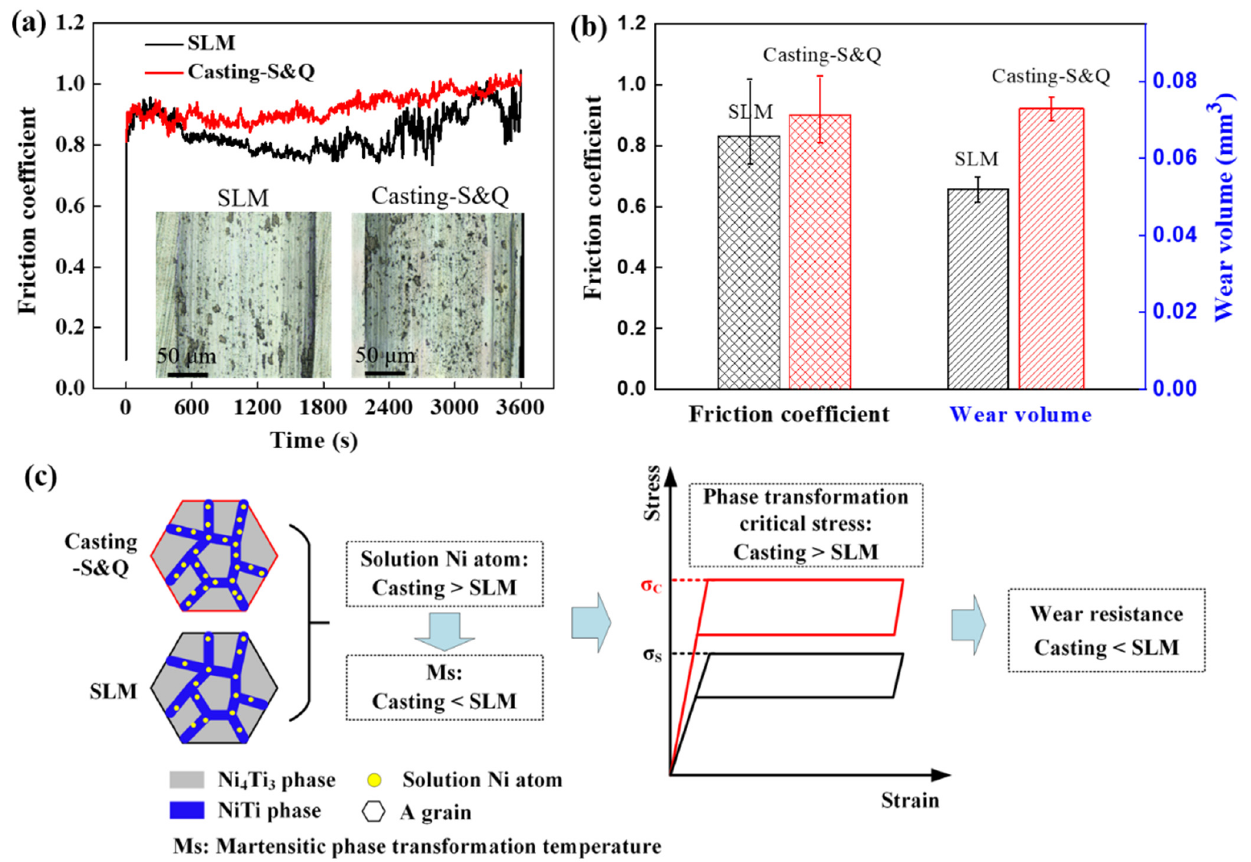
Figure 7. Wearing properties of the well-established SLM 60NiTi and conventional Casting-S&Q 60NiTi. ( a ) Friction coefficient curves; ( b ) summary results of friction coefficient and wear volume at three sampling positions for wearing test; ( c ) schematics reveal the mechanism of wear properties.